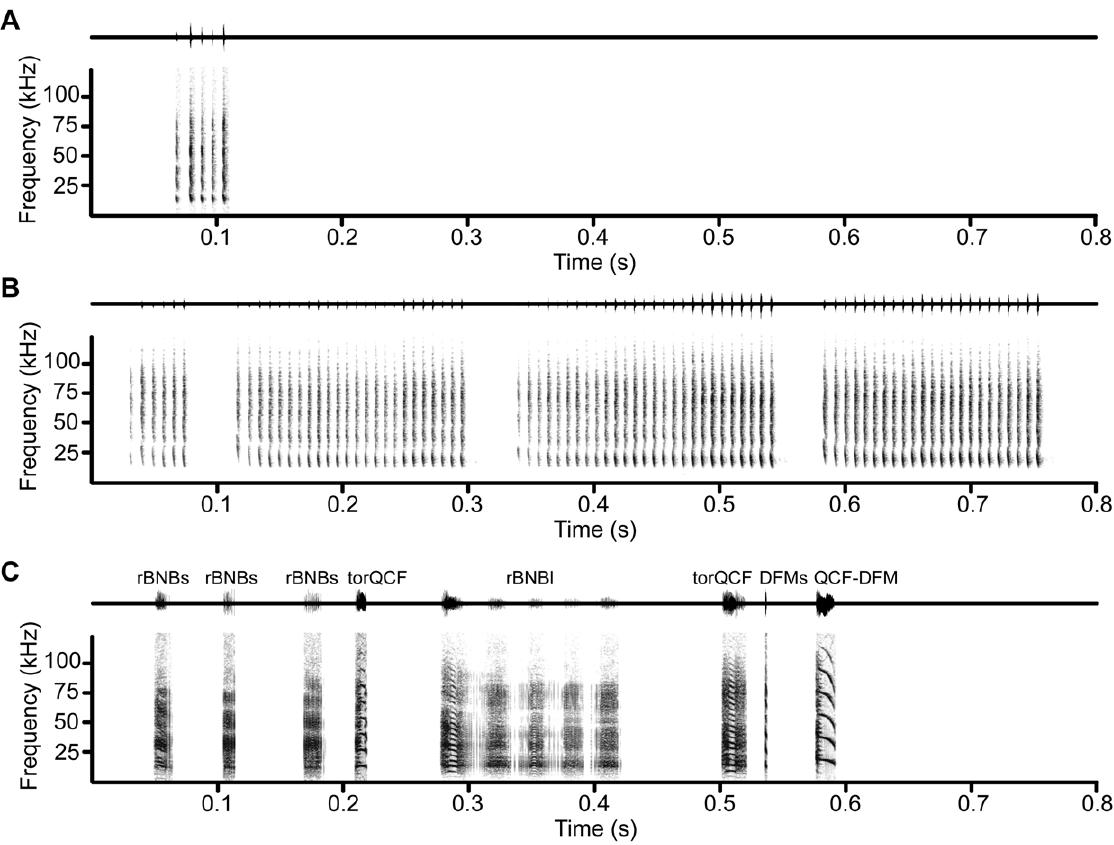
Figure 4. Example bouts of aggression vocalizations. Example waveforms ( upper trace ) and spectrograms ( lower trace ) of example vocal sequences emitted from the same bat during low aggression ( A ) and medium aggression ( B ) contexts. All syllables were classified as DFMs. The medium aggression bout lasts for an additional 2.1 s. ( C ) Example high aggression bout from a different bat, with syllable classifications above each waveform. Note that the rBNBl syllable includes a bifurcation of torus near the beginning of the syllable. Peak amplitude of the entire bout was normalized.